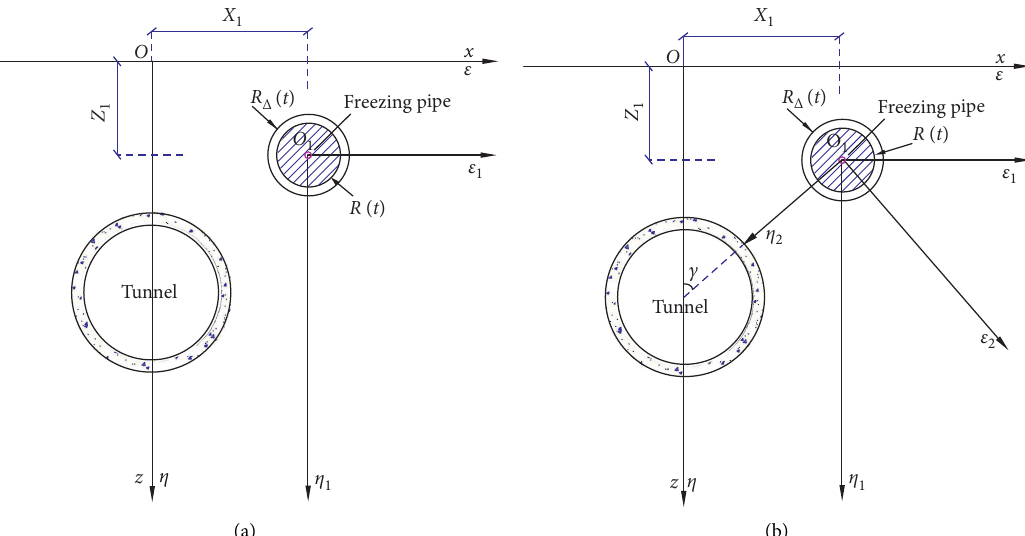
Figure 3: Coordinate transformation diagram: (a) Coordinate system ε